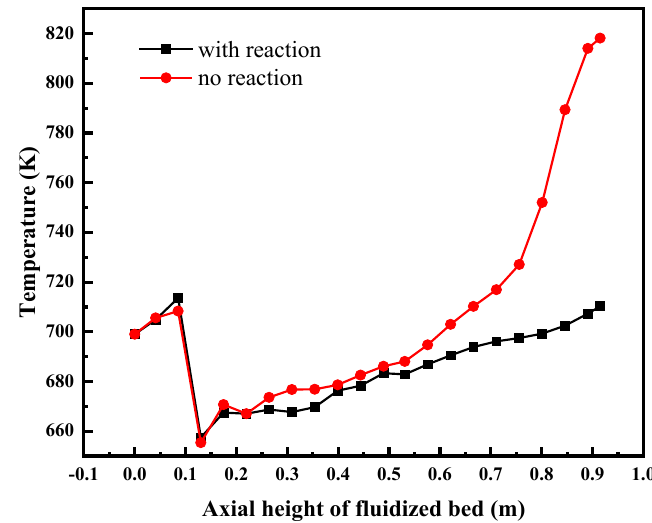
Figure 19. The temperature distribution of the central axis of the fluidized bed.